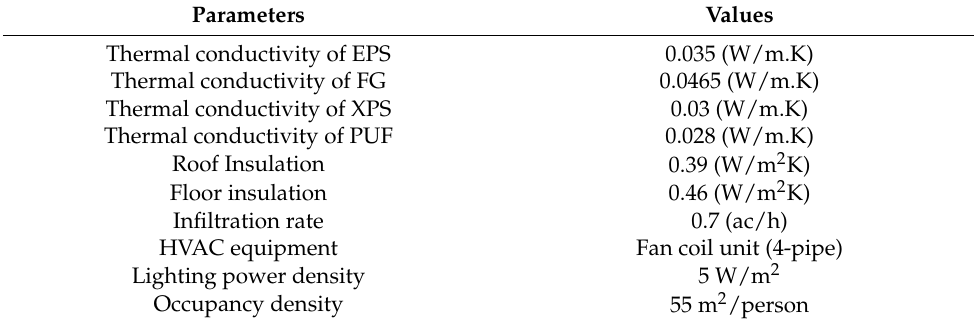
Table 2. Building Input Parameters *.